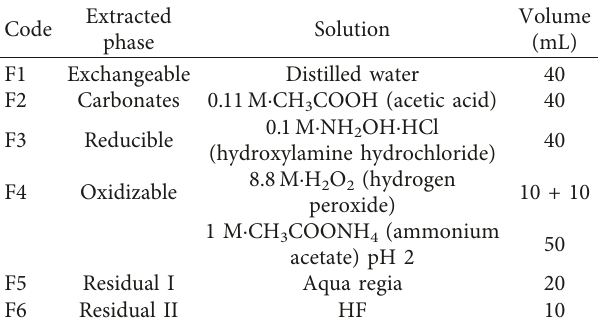
Table 1: Sequential extraction